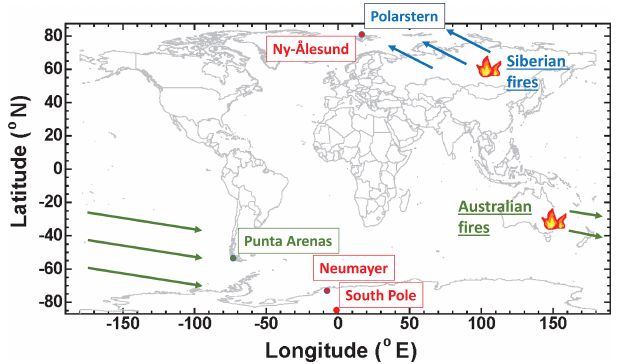
Figure 1. Global map showing the two lidar sites (aboard the ice- breaker Polarstern during the 1-year MOSAiC expedition and at Punta Arenas in southern Chile during the 3-year DACAPO-PESO campaign, the regions with major wildfires (Siberia, Australia), and the ozonesonde sites at Ny-Ålesund, Neumayer, and South Pole sta- tion. Arrows show the main smoke transport direction towards the Arctic and towards South America and Antarctica during the dis- persion